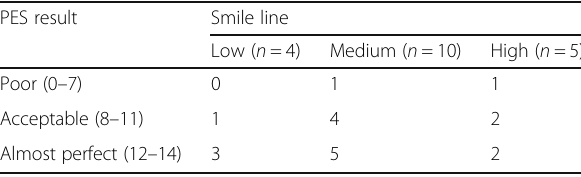
Table 5 PES of patients with different smile